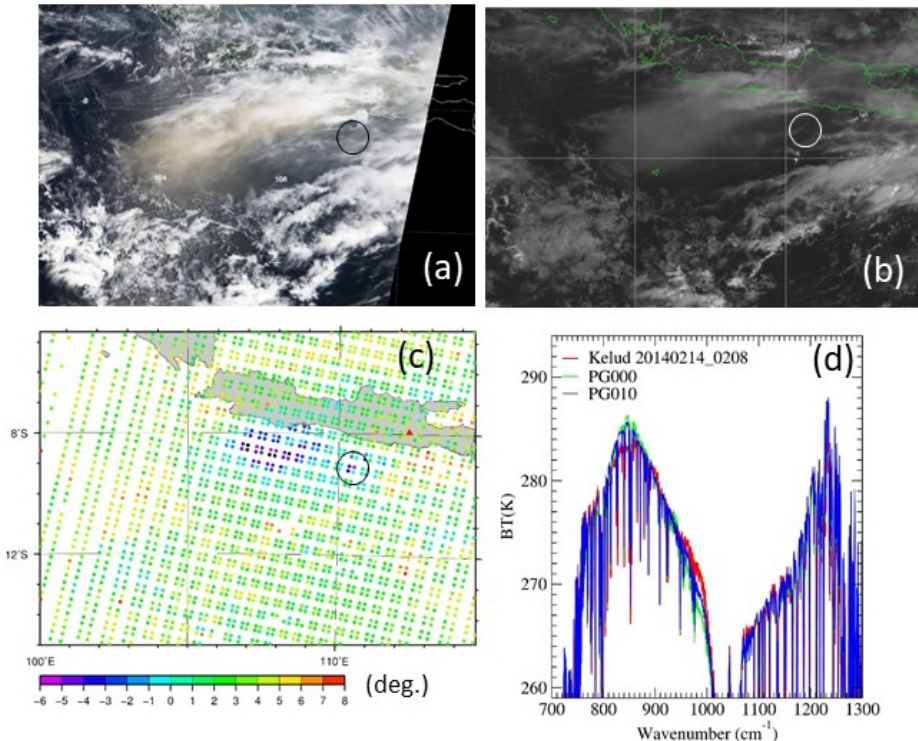
Figure 15. Kelud ash plumes on 14 February 2014. MODIS true-color image taken at 03:35UTC (a) and monochromatic Himawari-7 visible image taken at 02:00UTC (b) . (cid:49) BT split from the IASI measurement at 02:08UTC (c) and measured and calculated BTS for the pixel at (lat, long) = (9.101 ◦ S, 110.513 ◦ E) (d) (indicated by circles in a–c